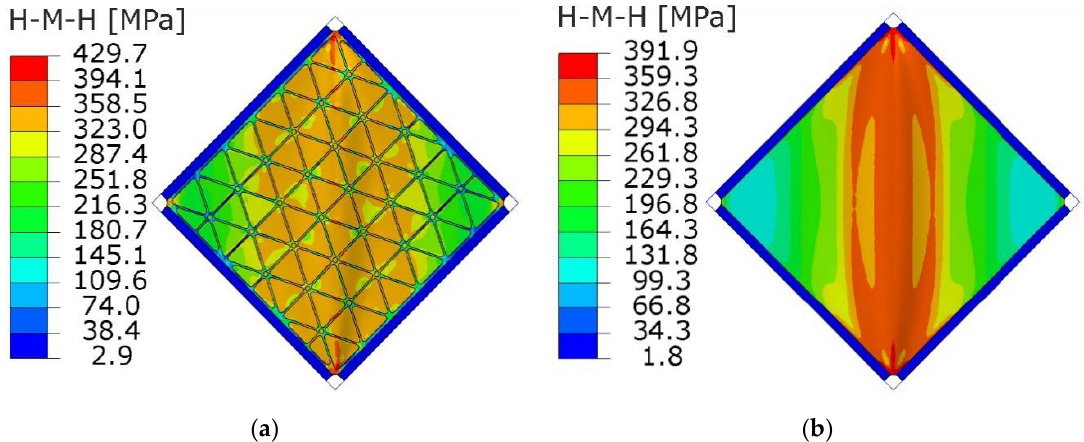
Figure 25. HMH stress distribution (MPa) obtained from FEM analyses at the level of load equal to 103 N/mm: ( a ) stiffened plate, ( b ) smooth plate.